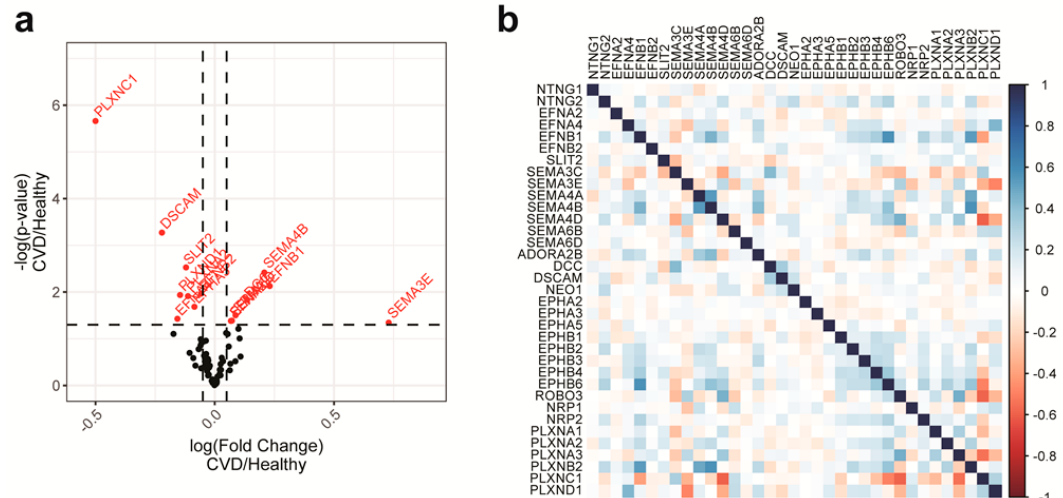
Figure 3. Univariate correlation of NGC expressions with disease phenotypes and pairwise correlations of NGC expressions. ( a ) Volcano plot showing the fold changes and the significance of difference in the 2 mean Student’s t -tests between NGC expressions in CVD patients and healthy individuals. NGCs with significant differences ( p < 0.05) are labeled with gene names and red color. For most NGCs, the univariate correlation determined by the 2 mean Student’s t -tests with the outcomes is minimal. ( b ) Pairwise covariances of NGC expressions were illustrated in the heatmap to examine the between-feature correlations. Blue color indicates a positive correlation, whereas red color indicates a negative correlation. There are no absolute pairwise covariances higher than 0.75, the common cutoff for highly correlated features.